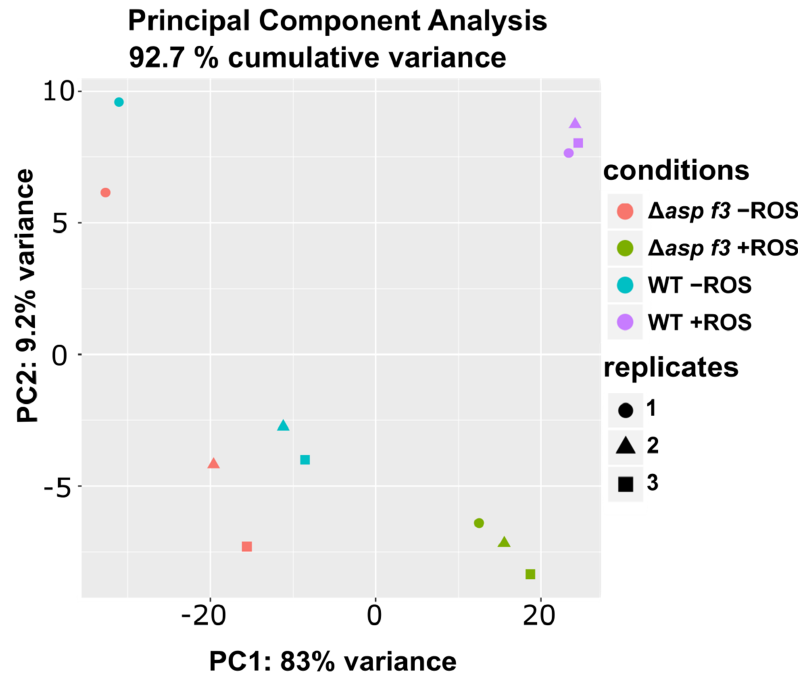
Figure 1. Principal component analysis of transcriptome data from wild type Aspergillus fumigatus (WT) and a strain lacking the asp f3 gene ( Δ asp f3 ) grown with (+ROS) or without ( − ROS) reactive oxygen species (ROS). The strains, treatments and biological replicates are represented by different colours and symbols, respectively. In fact, in the absence of ROS, WT and Δ asp f3 showed an exceptionally high similar- ity in their genome expression and only seven genes were found to be differentially ex- pressed genes (DEGs). The only DEG commonly identified by all four methods was asp f3 which remained undetected in the mutant strain, as expected . This indicated that Asp f3 plays a minor role in the absence of ROS and allowed a direct comparison of the ROS- treated samples without a background of genes that directly respond to the absence of Asp f3. ROS exposure induced a shift in the global transcriptome with nearly identical num- bers of DEGs for both strains. For the wild type and Δ asp f3 mutant we identified 1810 and 1729 ROS dependent DEGs, respectively. The numbers of up- and downregulated genes are likewise similar, identifying 1124 up- and 686 downregulated genes for the WT and 1025 up- and 704 down-regulated genes in Δ asp f3 (Figure 2A). However, when the DEGs were compared between the two strains, we found only about two thirds of them in con- gruency. This proportion was comparable for up- as well as for the down-regulated genes (Figure 2B).